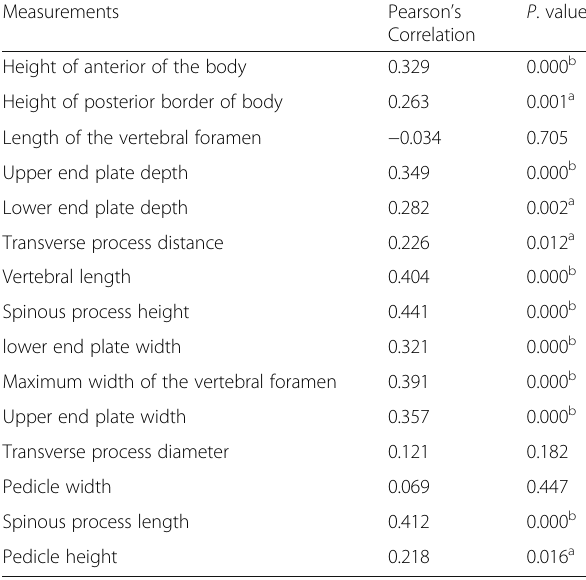
Table 3 The correlation between age and L1 measurements Measurements Pearson ’ s